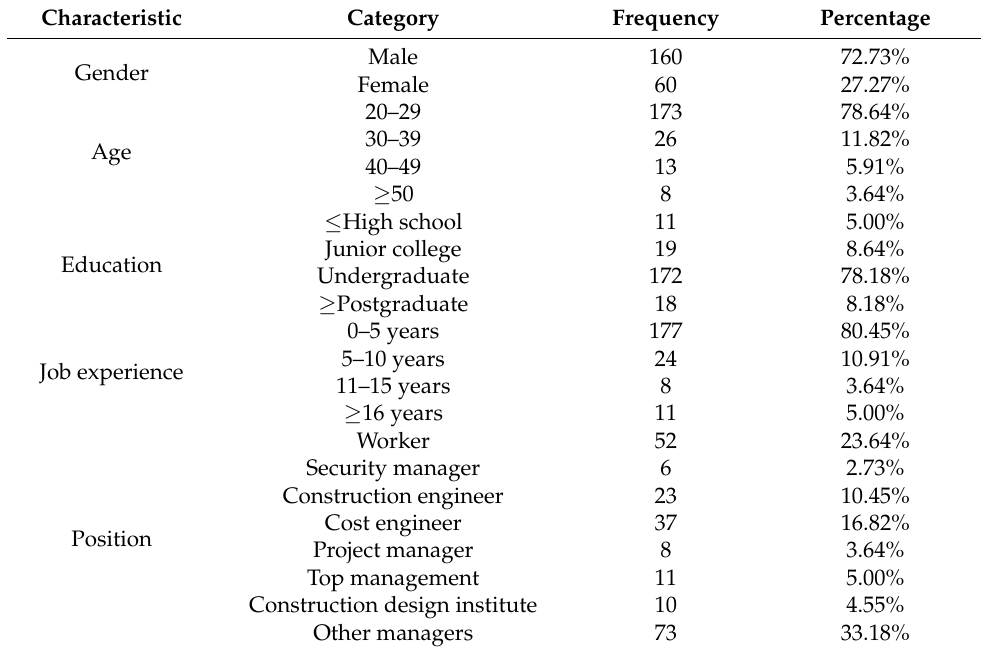
Table 1. Demographic characteristics of the respondents.